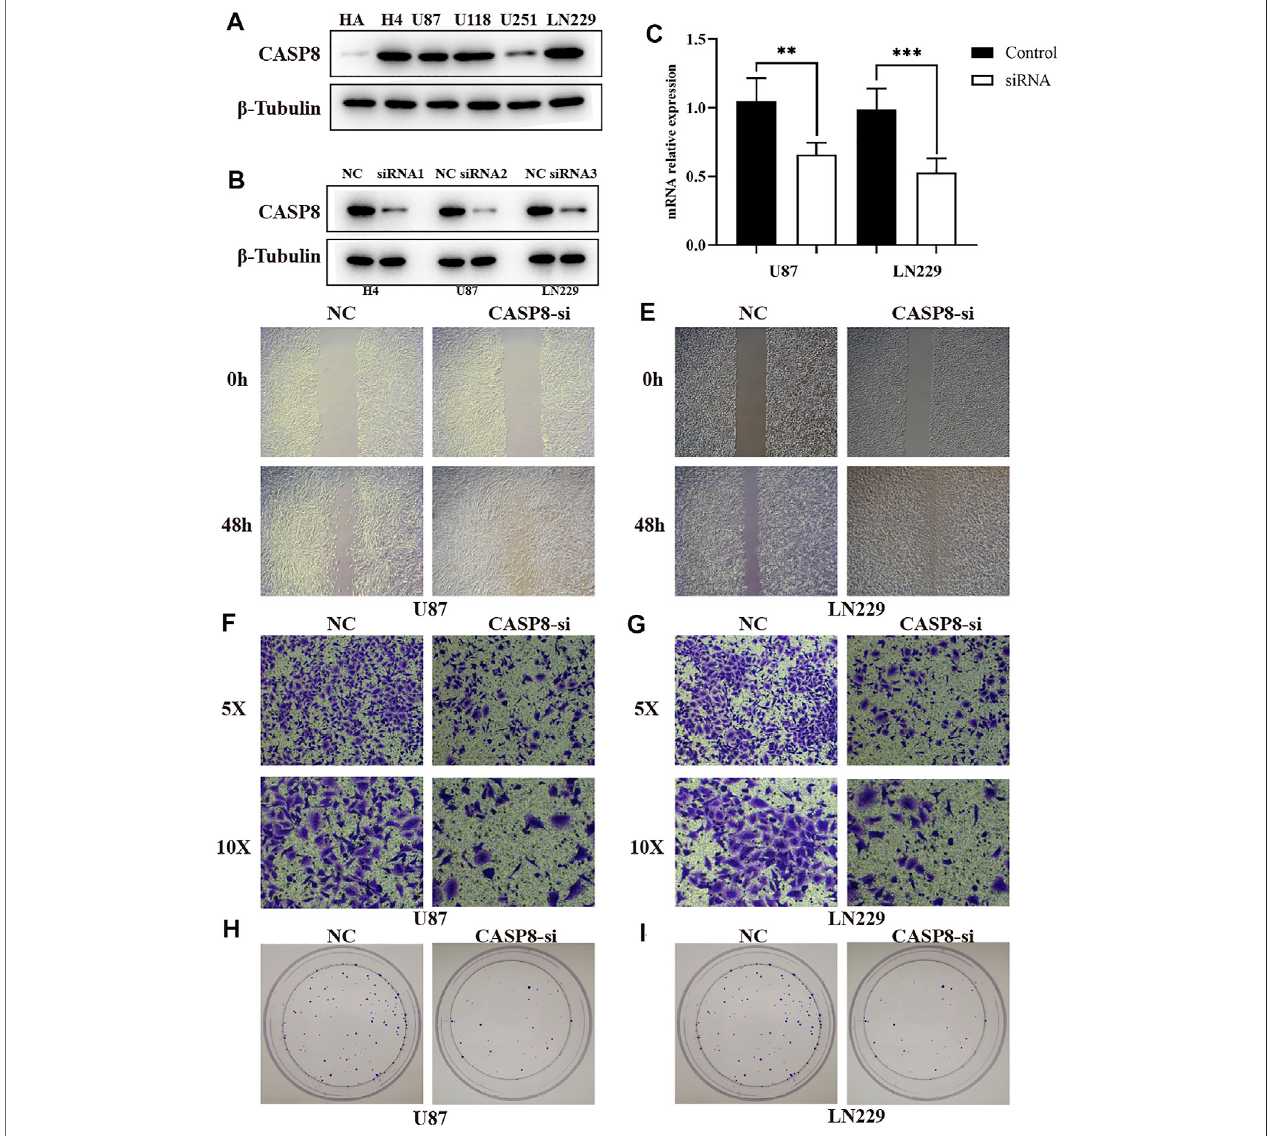
FIGURE10| CASP8promotesprogressionofgliomacells. (A) TheexpressionofCASP8proteininhumanHAandgliomacelllines. (B) ThewesternblotofCASP8 inU87,U1251,H4celllinesaftersiRNA. (C) ThemRNAexpression levelofCSAP8inU87andU251aftersiRNA. (D,E) ThescratchassayofCASP8-siinU87andU251 cell lines. (F, G) Transwell assay of CASP8-si U87 and U251 cell lines. (H, I) The clonogenic assay of CASP8 in U87 and U251 cell